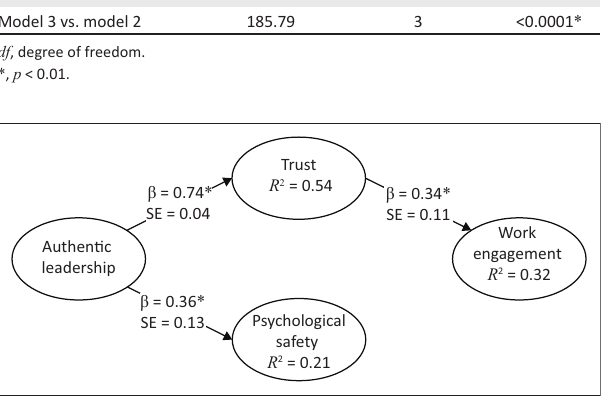
FIGURE 2: Standardised path coefficients for the best-fitting model. Note: Only statistically significant paths are included in the